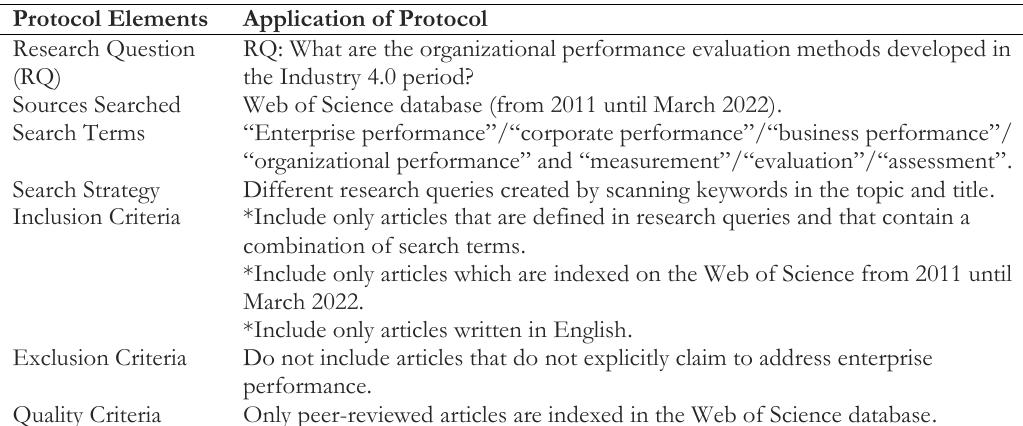
Table 1. SLR Protocol to determine organizational performance models developed in Industry 4.0